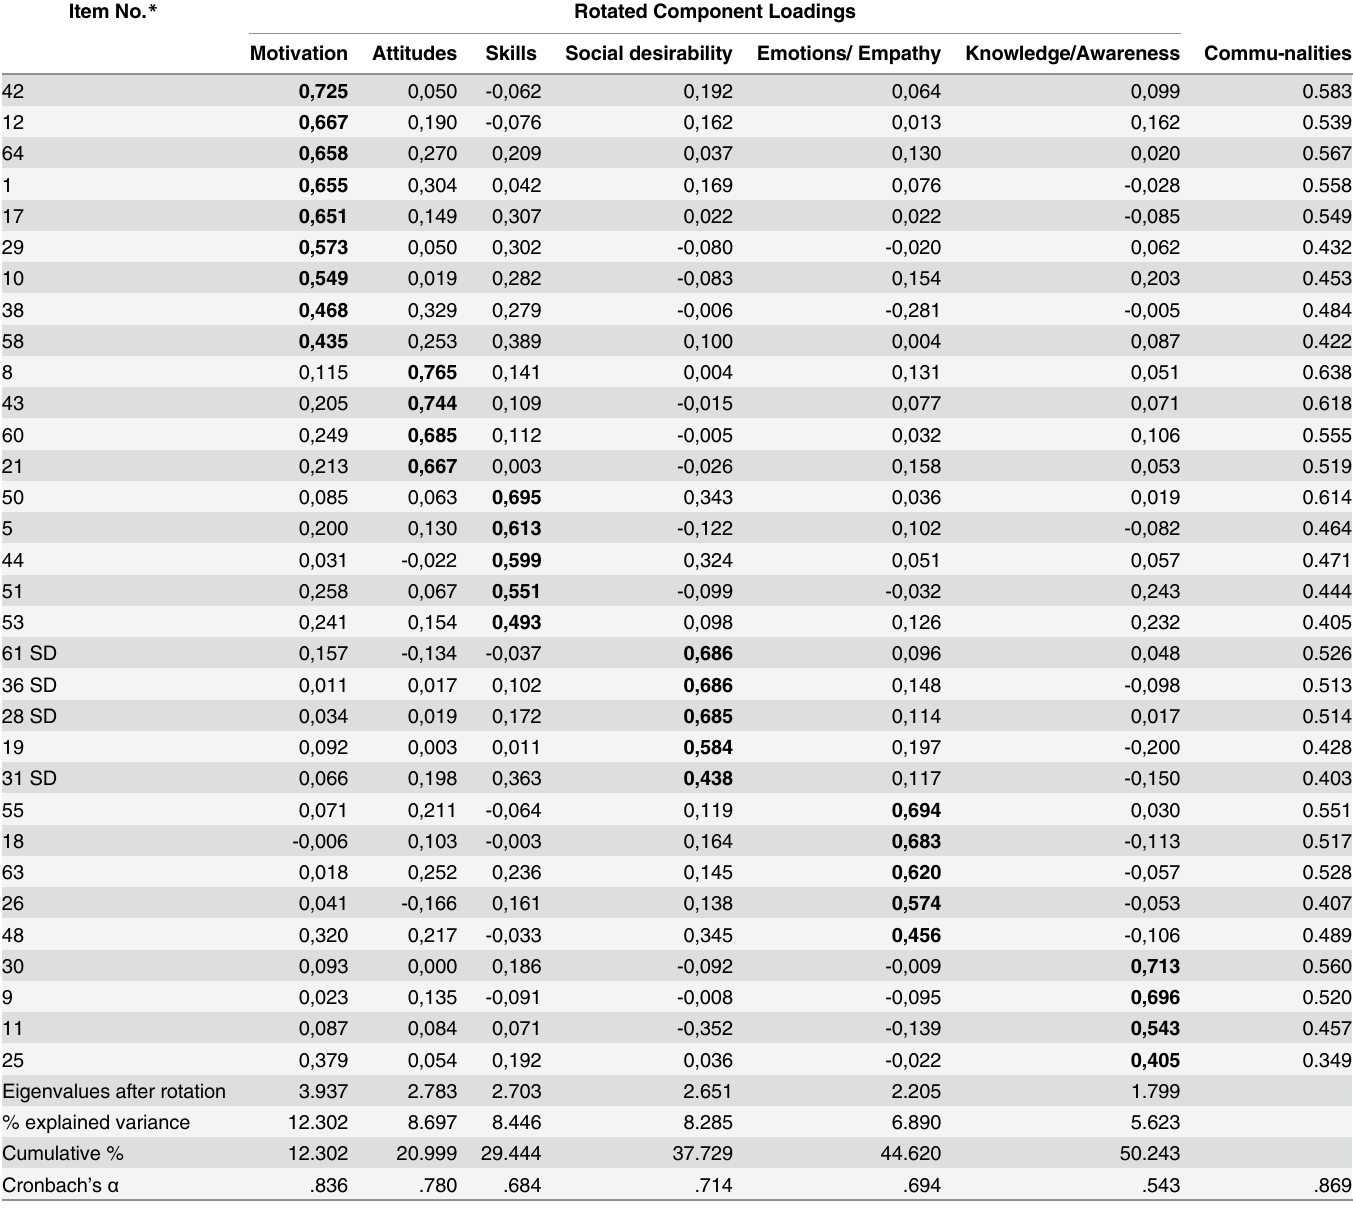
Table 2. Principal component analysis with varimax rotation. Final six-component solution with Cronbach ’ s α of each component. Item No.